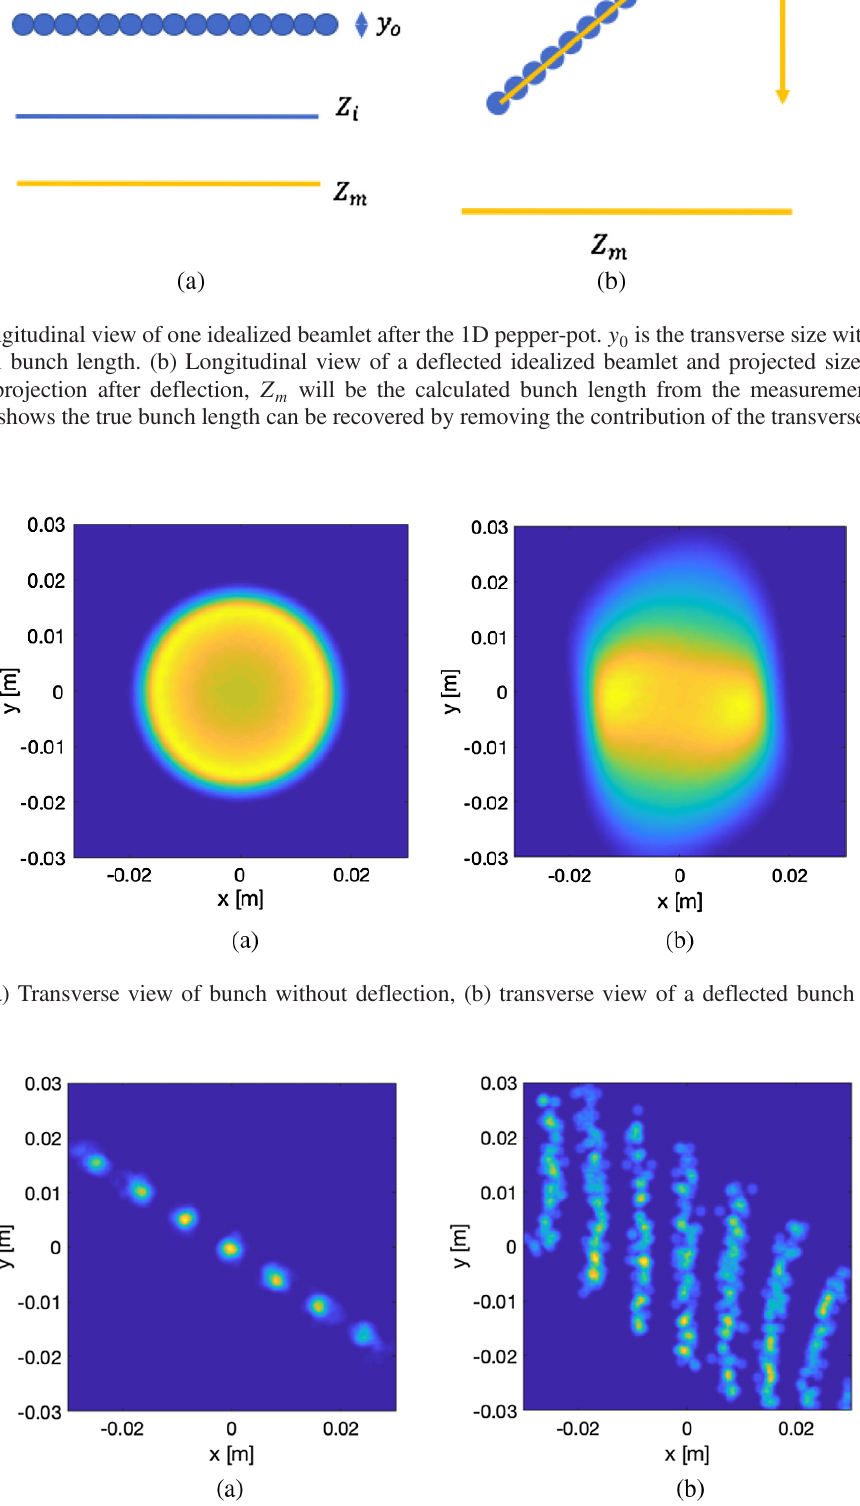
FIG. 8. (a) Transverse view of beamlets without deflection, (b) transverse view of all deflected beamlets at